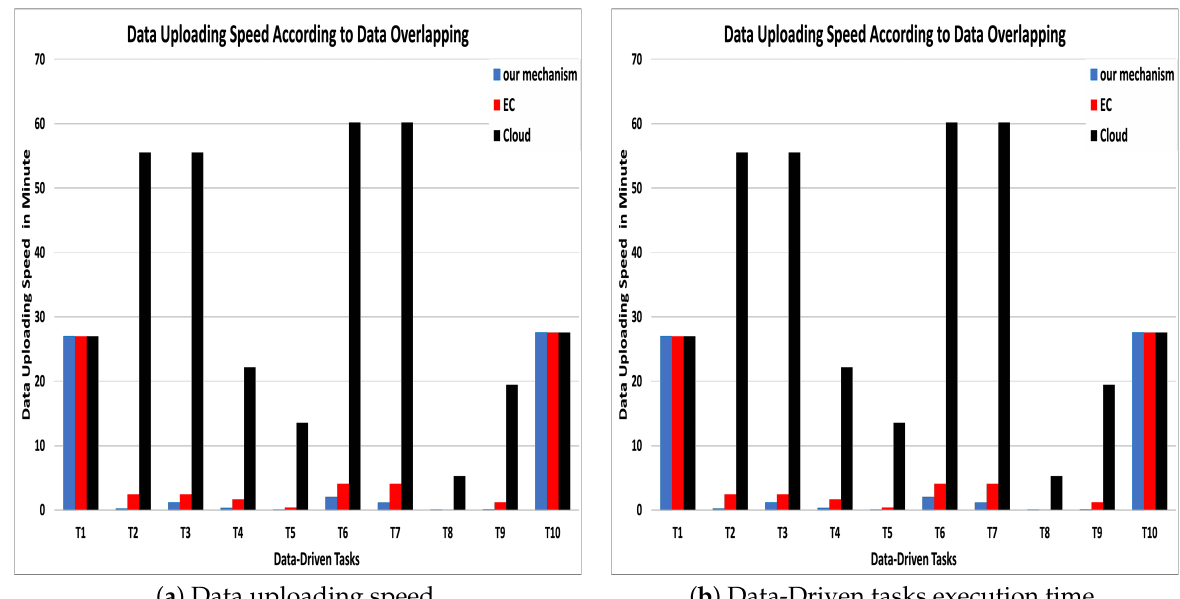
Figure 6. Data uploading speed and tasks execution Time.